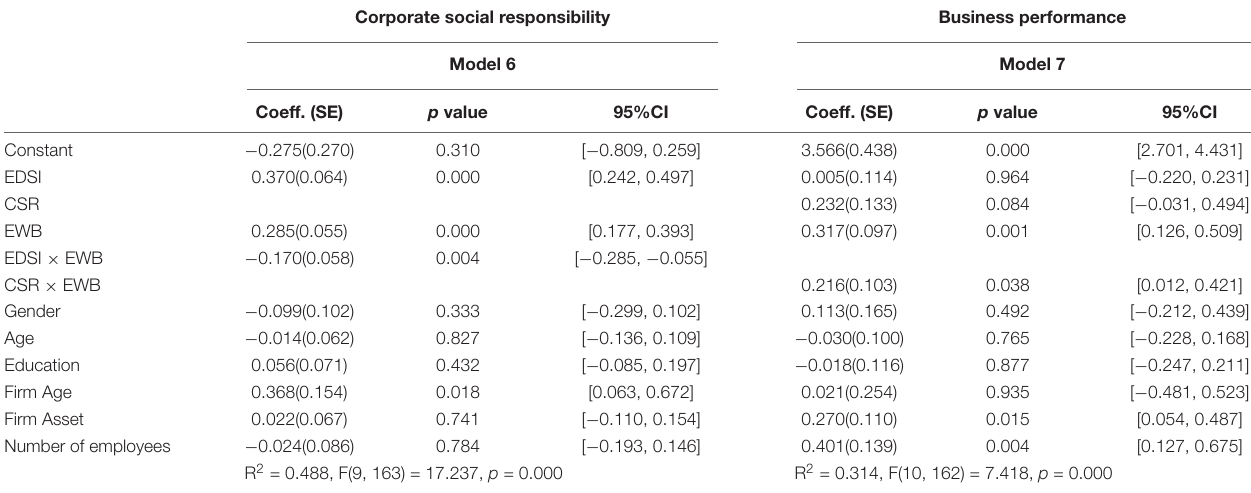
TABLE 6 | The moderating effect of entrepreneurs’ well-being.